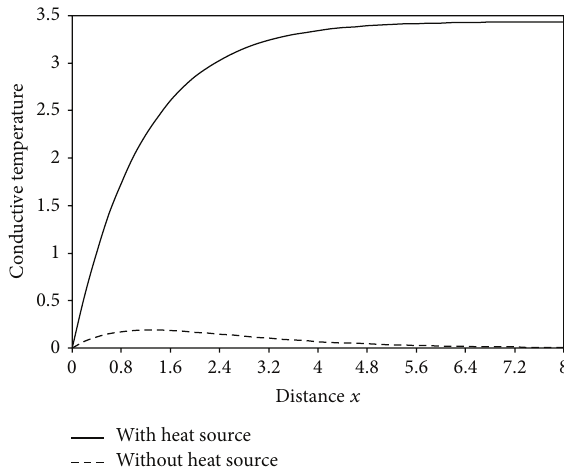
Figure 16: Distribution of conductive temperature with distance 𝑥